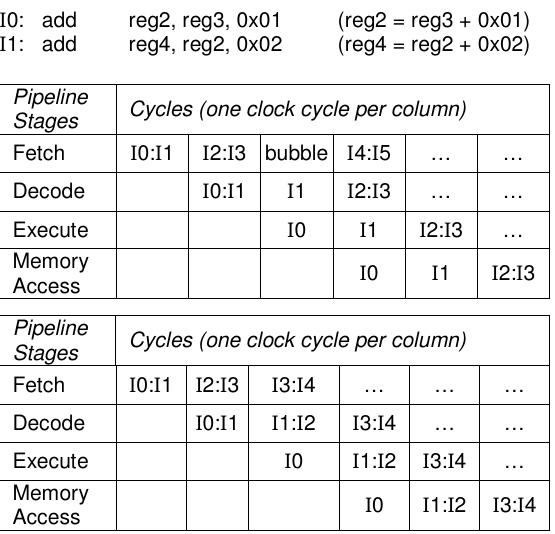
Figure 13. Example (top) of a true dependency between instructions within the same cycle and (bottom) a proposed solution to reduce the number of wasted instruction